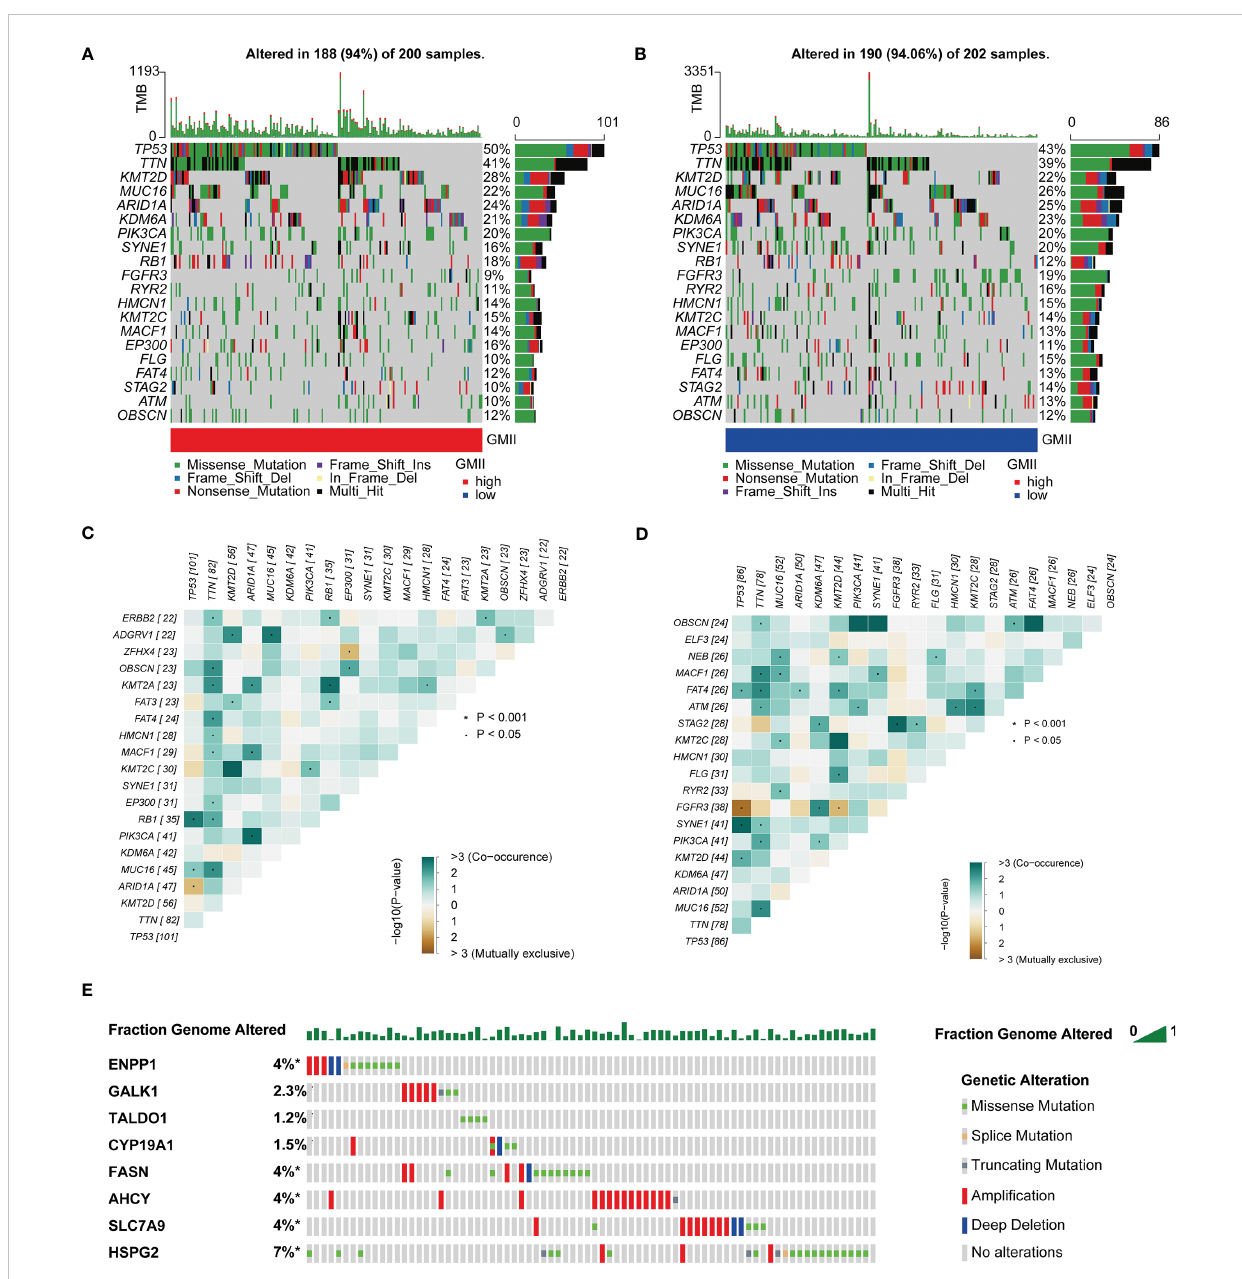
FIGURE 6 Association of GMII with genetic changes. Waterfall diagrams of somatic mutations in high-GMII (A) and low-GMII (B) groups. Mutual exclusion and synergistic heat maps of mutated genes in high-GMII (C) and low-GMII (D) groups. (E) Mutation rates of the eight GRGs that constructed